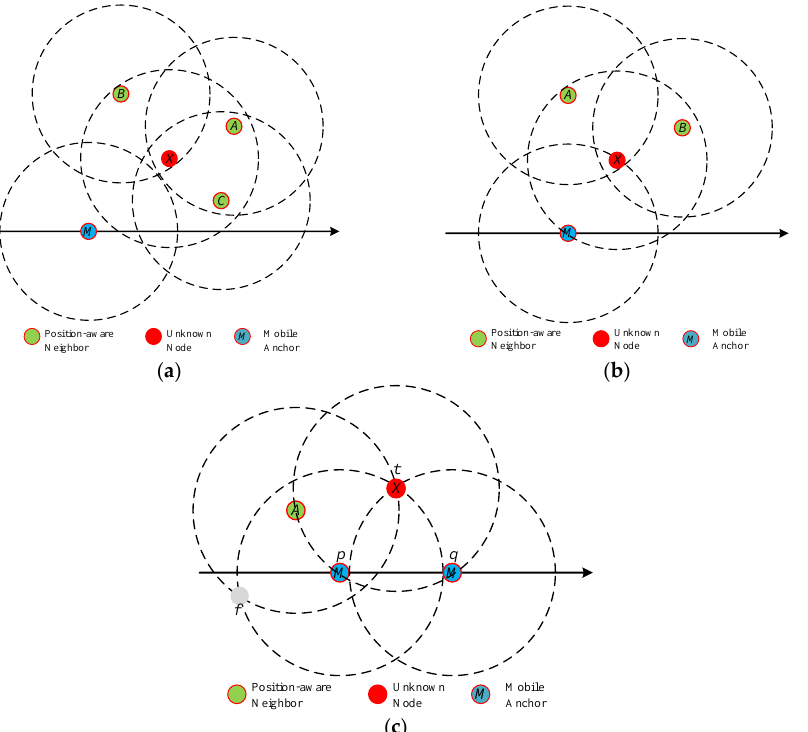
Figure 2. Three cases in which the ISP algorithm is able to directly locate an unknown node: ( a ) the unknown node has three position-aware neighbors; ( b ) the unknown node has two position-aware neighbors; ( c ) the unknown node has one position-aware neighbor.